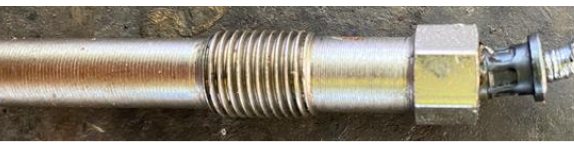
Fig. 6. A glow plug failure due to a broken thread on the power connection end in relation to the glow plug used in the 2013 Peugeot Boxer 2.2 HDI engine. Source: own elaboration